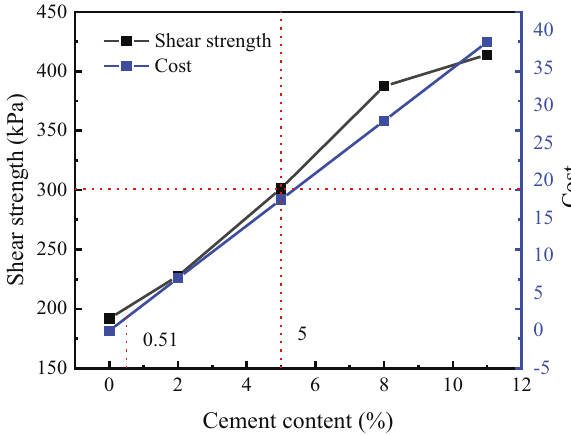
Figure 14: In fl uence of strength and cost on cement